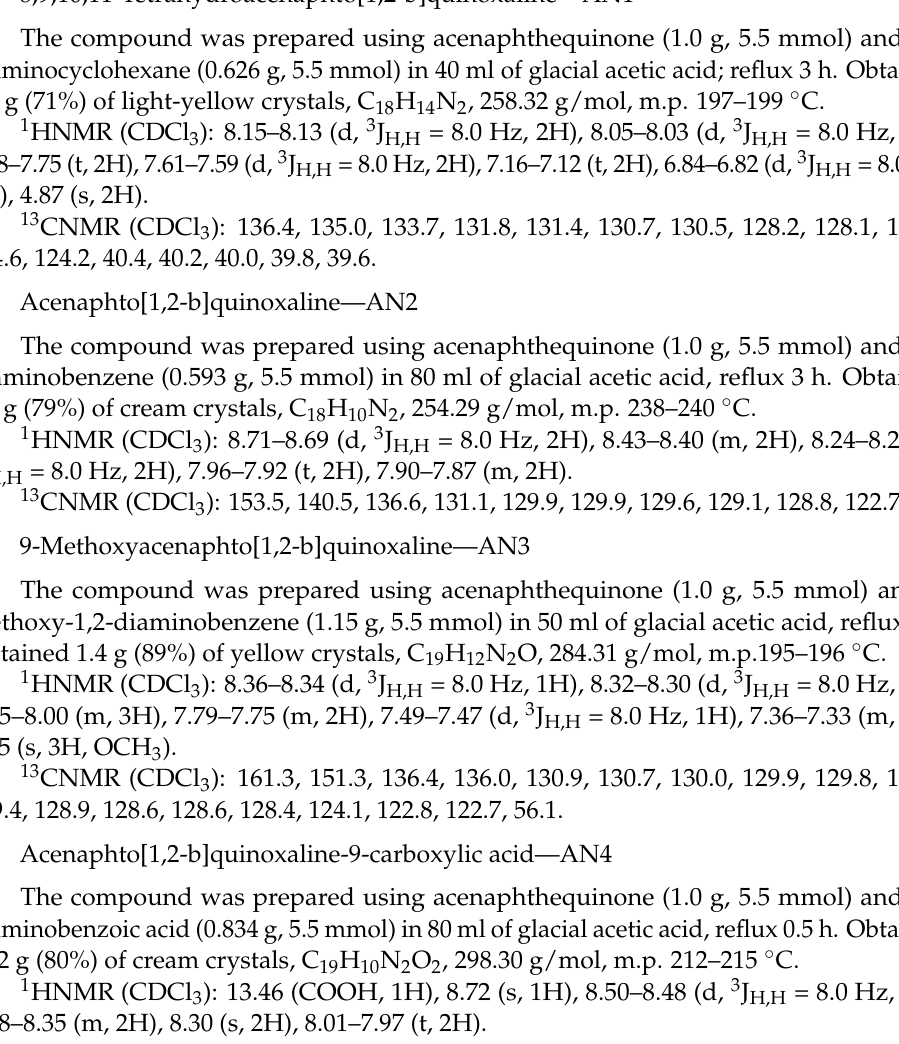
Scheme 6. Synthesis routes of acenaquinoxaline derivatives (AN5–AN8) differing in the arrange- ment of aromatic rings (linear or angular) and the number and position of nitrogen atoms in the